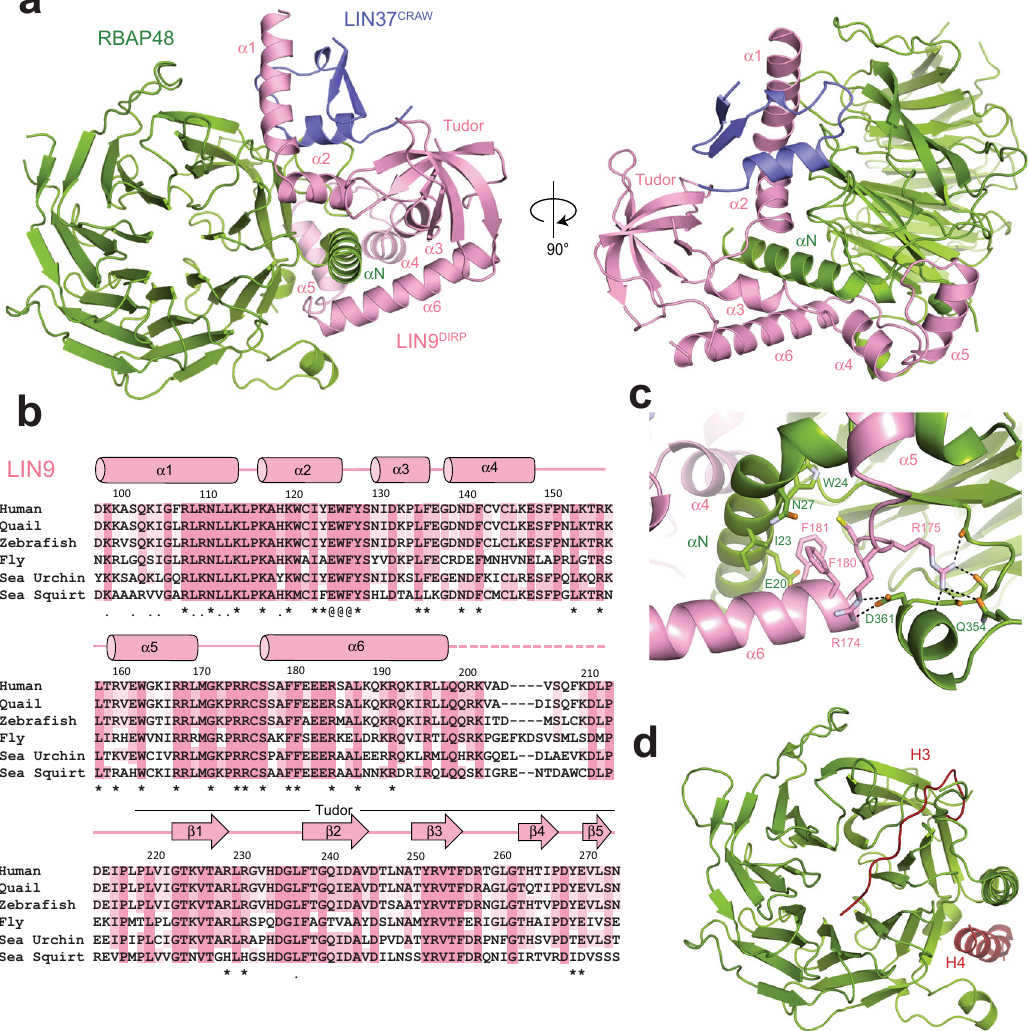
Fig. 2 Structure of the MuvBN subcomplex. a Overall structural model. b Alignment of LIN9 sequences from H. sapiens , C. japonica , D. rerio , D. melanogaster , S. purpuratus , and C. intestinalis . The (*) marks residues that contact RBAP48, the (.) marks residues that contact LIN37, and the (@) marks residues that contact both. c Close-up view of one interface between LIN9 and RBAP48. d Location of histone H3 and histone H4 peptide binding sites on RBAP48. When bound to LIN9, the H4 sites is blocked while the H3 site is mostly accessible. The model was generated from PDB IDs: 2YBA and